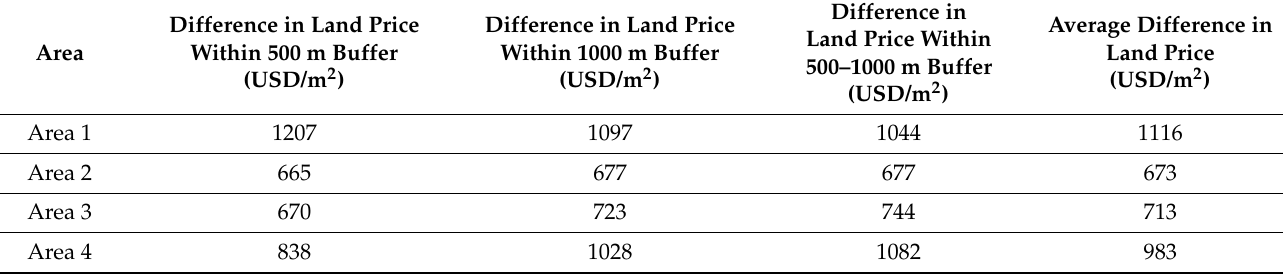
Table 5. Differences in land price based on area and buffer size.